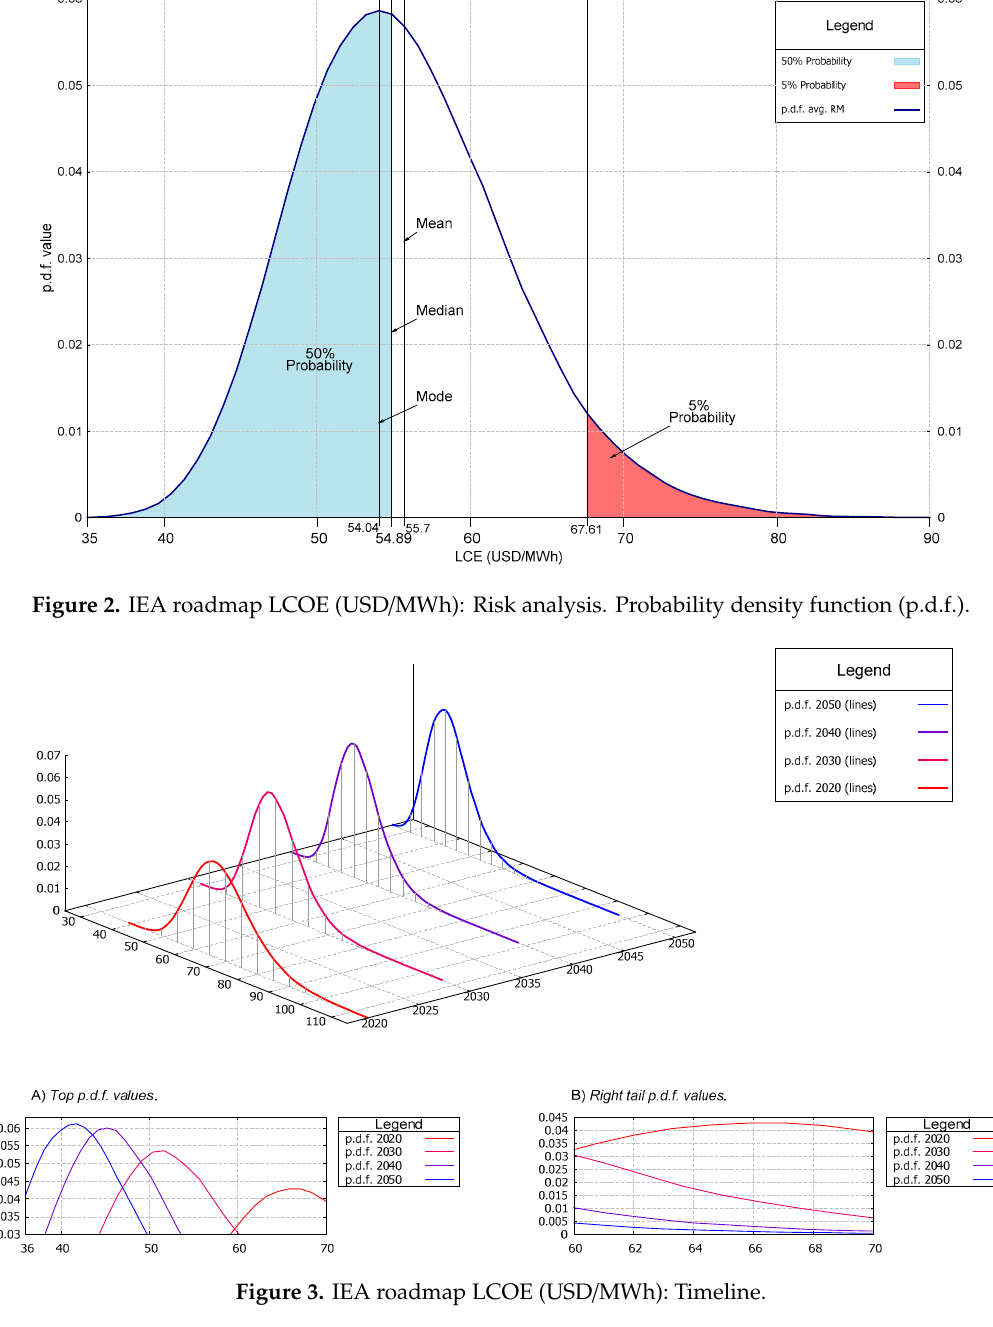
Figure 4. IEA Roadmap LCOE (USD/MWh): PV, wind and overall values.